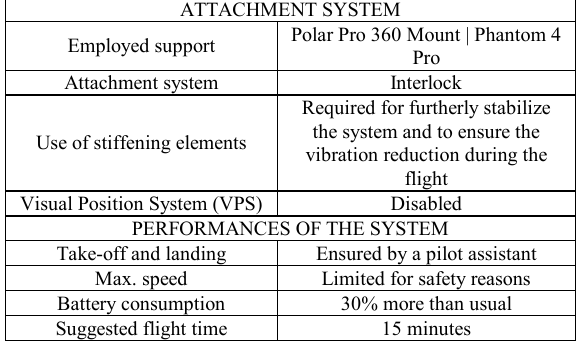
Table 3. Configuration of the employed UAV with the 360° camera attached and information regarding the change in